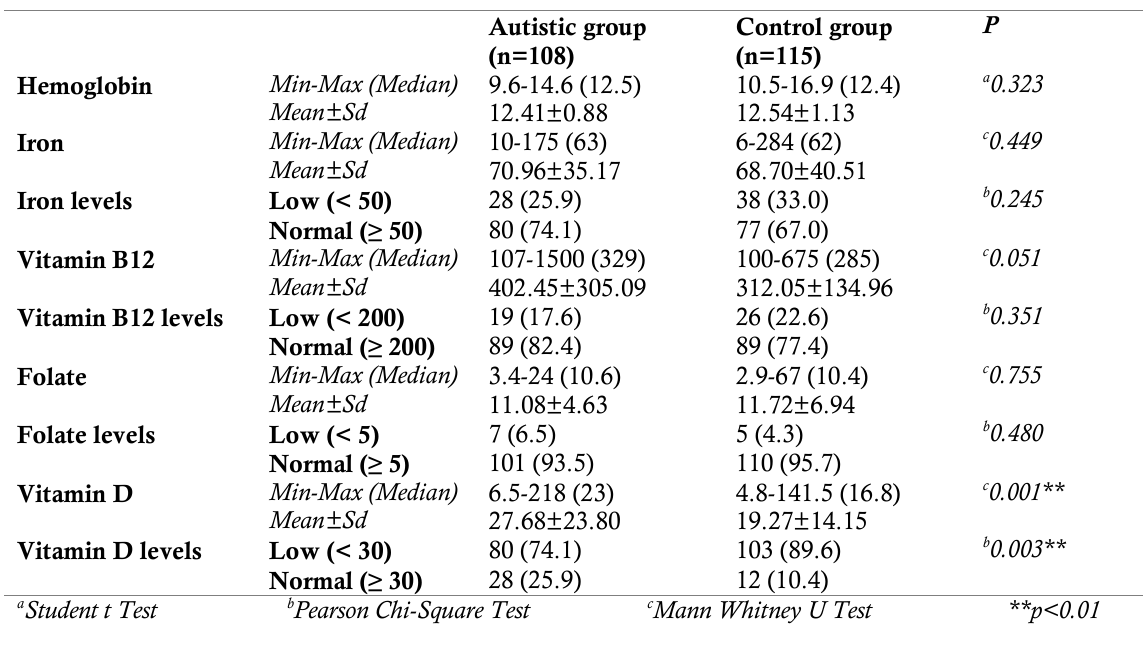
Table 6 . Evaluation of CARS Levels by Descriptive Characteristics